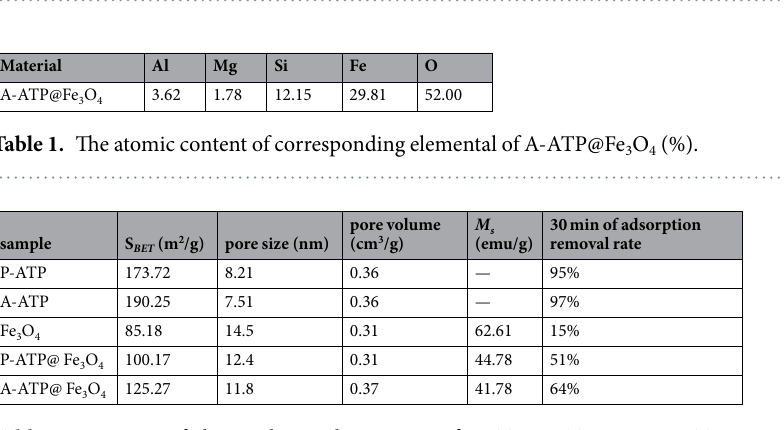
Table 2. Summary of physicochemical properties of P-ATP, A-ATP, Fe 3 O 4 , P-ATP@Fe 3 O 4 , and A-ATP@Fe 3 O 4